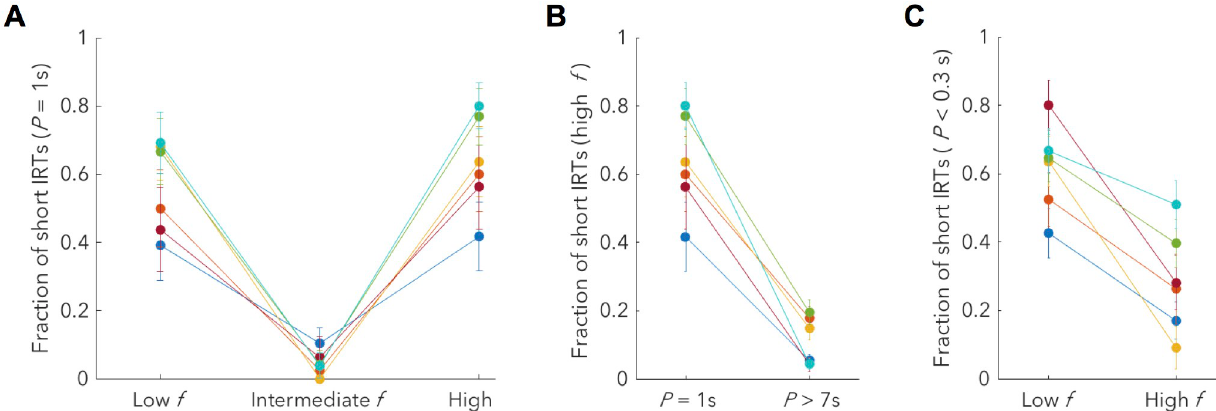
Fig 4. Subjects use multiple sources of evidence from the preceding test trial to determine a response on the trail trial. ( A ) Intermediate test trial frequencies only very rarely lead to short trail trial IRTs, even when price and duration are misleading. This indicates that subjects can use frequency to determine the appropriate response when this frequency is different from that of lead or trail trials; see Materials and methods for a definition of these regions. This difference is significant for all subjects when comparing intermediate to both ‘Low f’ (binomial proportion test; h 7 ) and ‘High f’ (binomial proportion test; h 8 ) categories. ( B ) High test trial prices also only rarely lead to short trail trial IRTs even when frequency is misleading (here we show for high, lead-like frequency). As duration is perfectly correlated with price for prices of 1 second or greater, this indicates that subjects can use price and/or duration to determine the appropriate response. The difference between the two categories is significant for all subjects (binomial proportion test; h 9 ). ( C ) When test trial price is short, test trial duration remains at 25 seconds, thus we consider cases in which price is not misleading ( < 0.3s) but duration and frequency are. Short trail trial IRTs depend on the frequency of the preceding test trial. When the frequency is low, subjects respond with a similar fraction of short responses as for a price of 1s (Fig 4A; left), indicating price insensitivity. However, when the frequency is high, subjects are price sensitive, with a decreased fraction of short responses. This difference was significant for 4/6 subjects (binomial proportion test; h 10